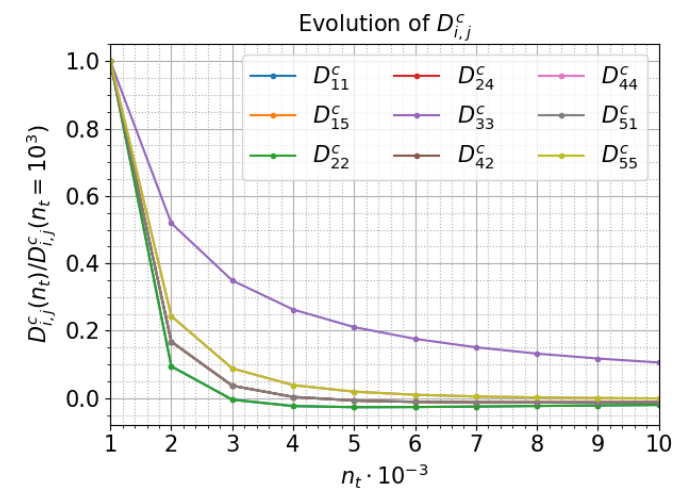
Figure 8. Evolution of D c when increasing n t